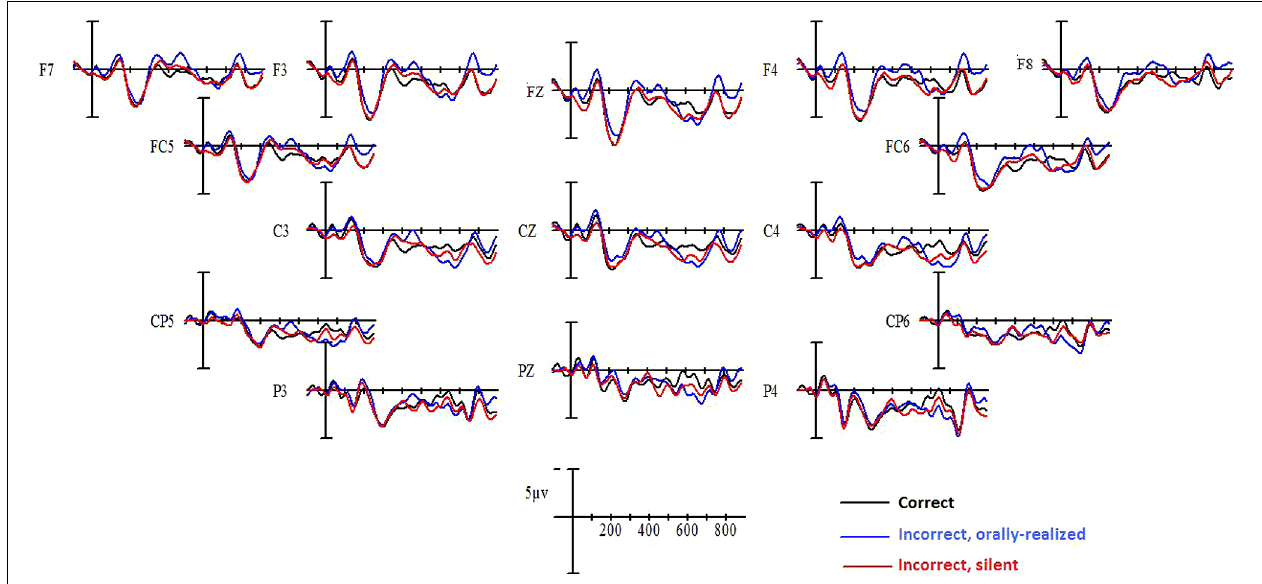
FIGURE 3 | Grand mean averages for native French speakers as a function of verbal inflection condition and electrode site.